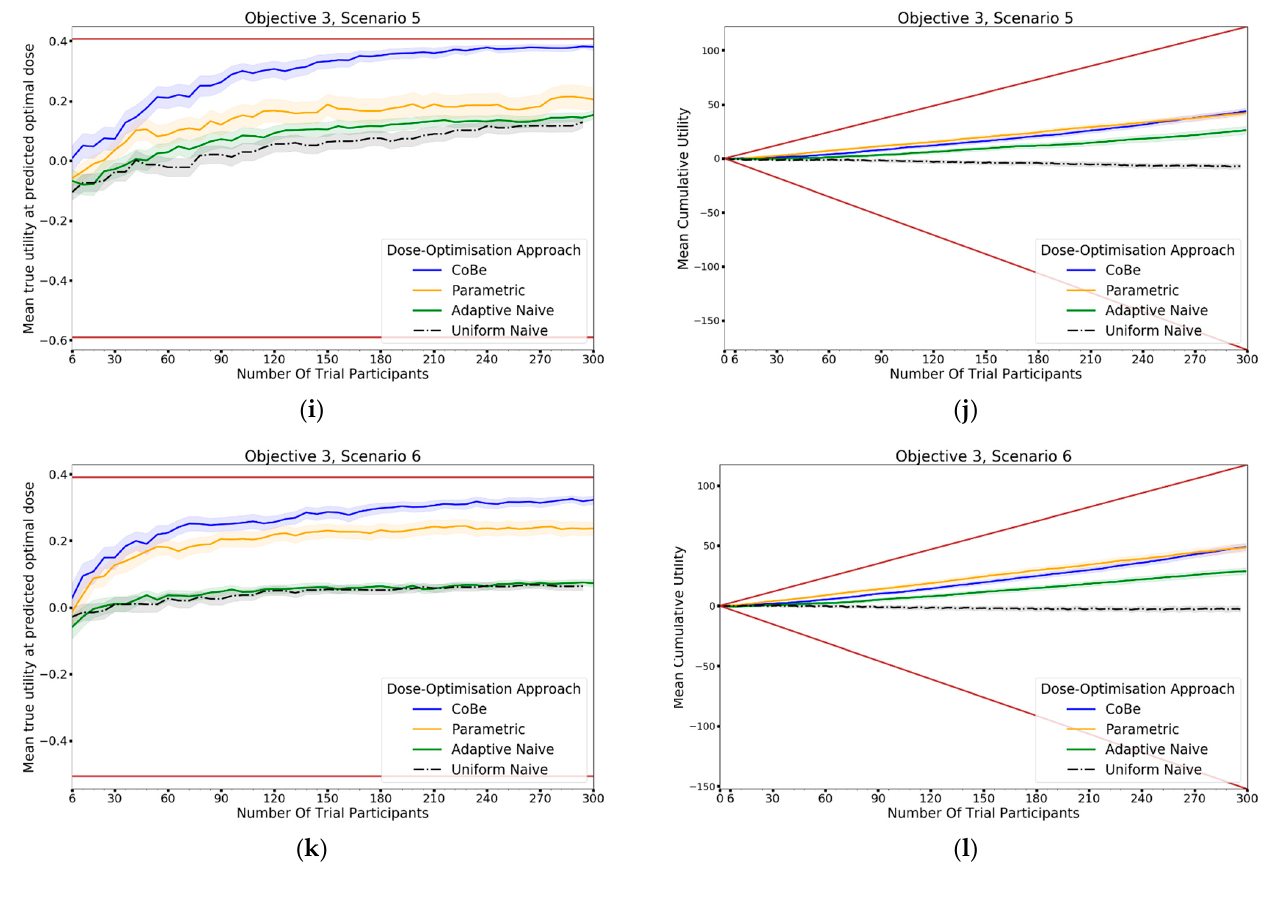
Figure 12. Mean true utility at the predicted optimal dose (left) and mean cumulative sum of utility (right) against trial size for all six objective 3 scenarios (Scenario 1 ( a , b ), Scenario 2 ( c , d ), Scenario 3 ( e , f ), Scenario 4 ( g , h ), Scenario 5 ( i , j ), Scenario 6 ( k , l )). These are the mean values and 95%CI values across 100 simulations. For the true utility at the predicted optimal dose plots (left), the brown lines show the minimum and maximum possible utility that could be achieved in that scenario. For the cumulative efficacy plots (right) the brown lines represent the maximum and minimum cumulative utility sum that could be expected for that scenario.